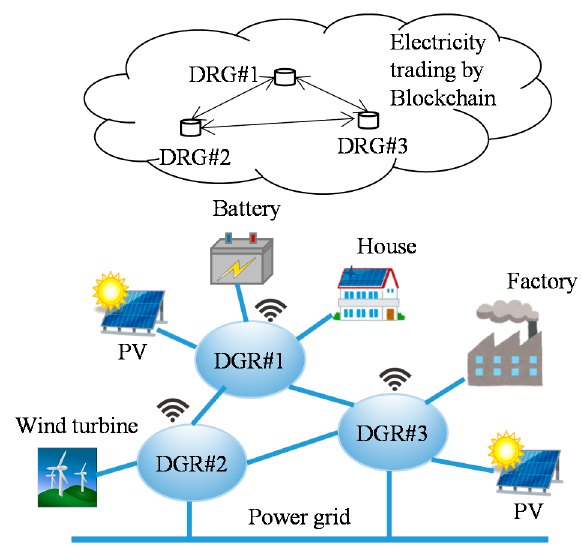
Figure 1. Digital grid system with electricity trading using block-chain.